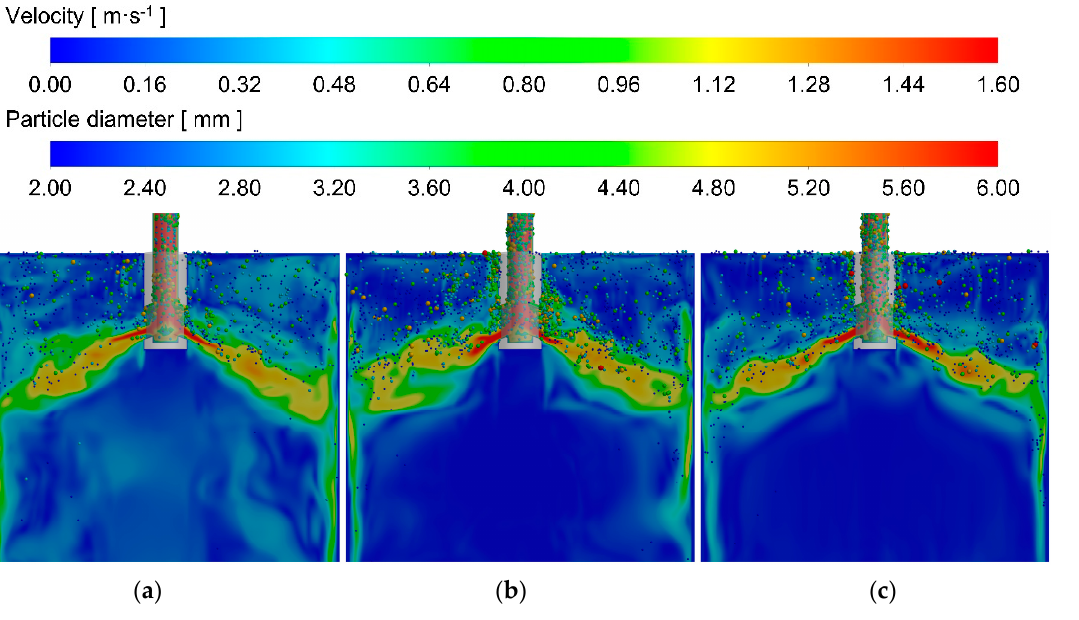
Figure 10. Contour diagram of instantaneous velocity and distribution of argon bubbles in the mold at argon flow rate of 6 L·min − 1 and under different EMBr modes of: ( a ) Mode 1, ( b ) Mode 2, ( c ) Mode 3.